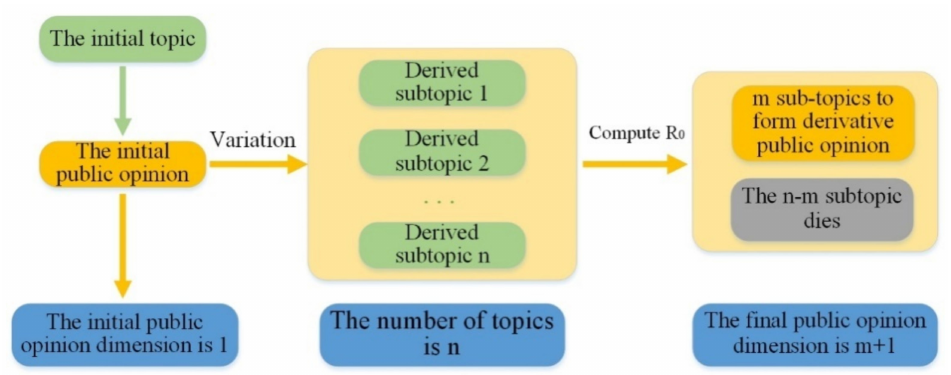
Figure 1. Research